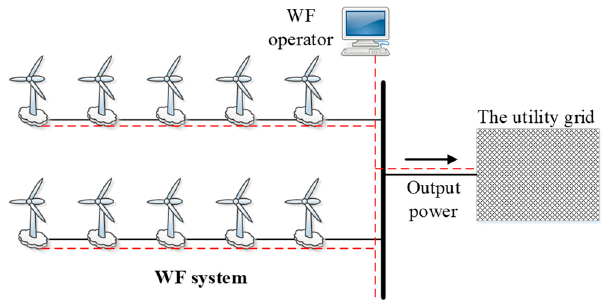
Figure 4. Tested WF system configuration.